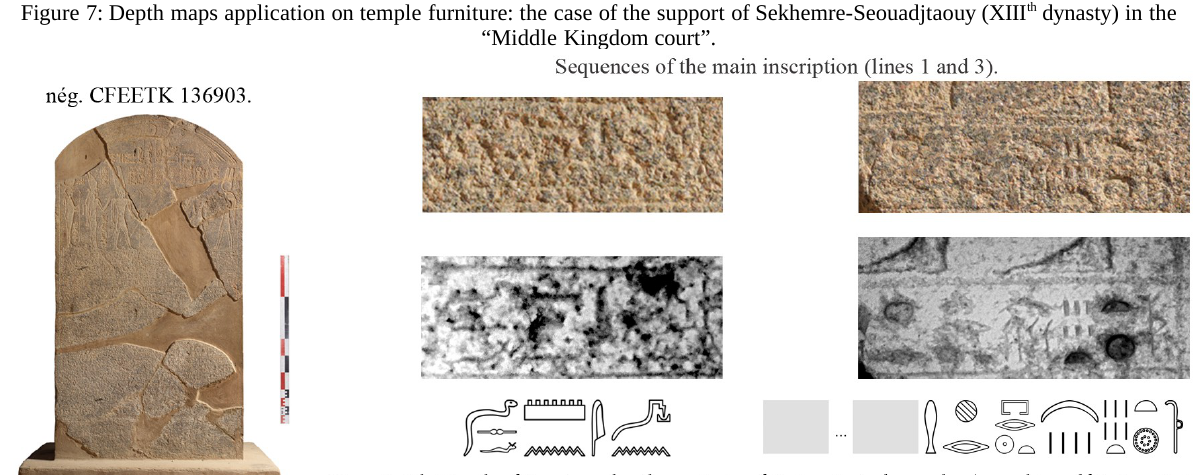
Figure 8: Depth maps application on hammered royal stele in granodiorite from the First Court.